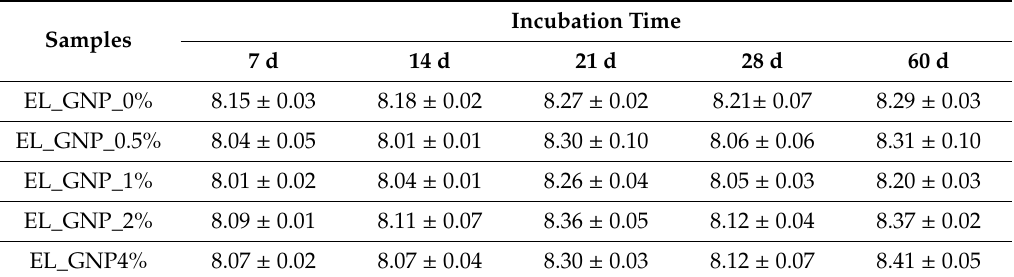
Table 4. pH measurement of incubation medium from in vitro degradation test withdrawn at 7, 14, 21, 28 and 60 d of incubation. Results expressed as mean ± SD ( n =